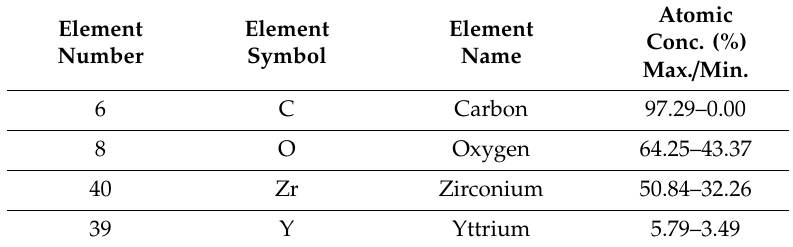
Table 5. Chemical analysis of particulate residues on monotype zirconia samples before ultrasonic cleaning by element and maximum / minimum atomic